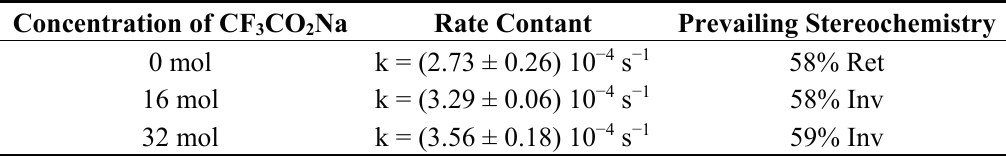
Table 10. The effect of concentration of sodium trifluoroacetate on the rate constants and stereochemistry of the reaction